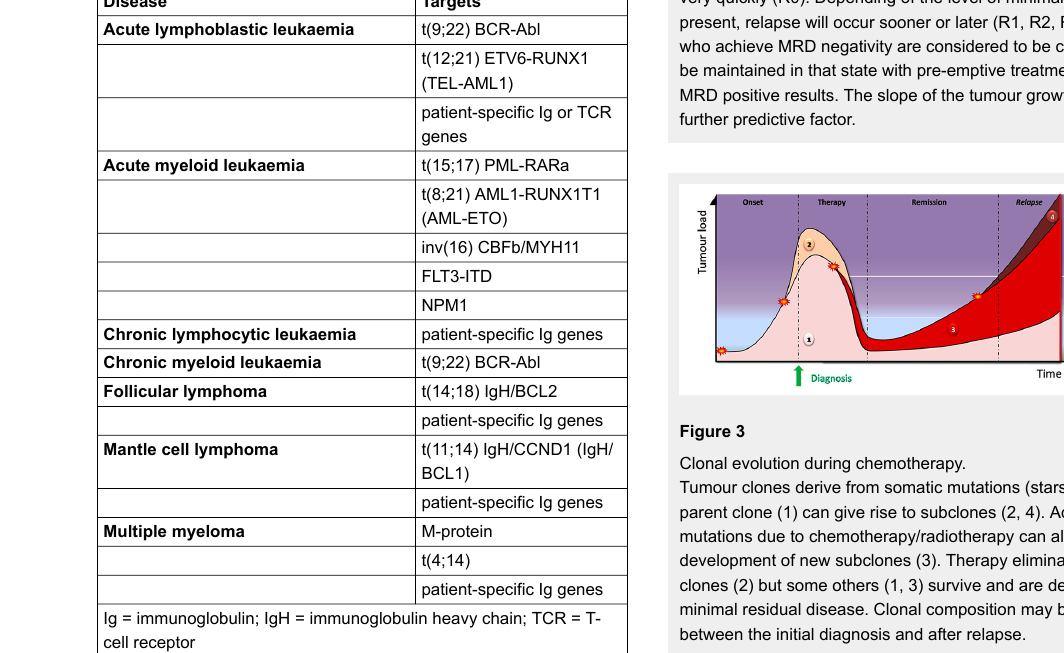
Table 1: Most common genes and translocations used for detection of minimal residual disease. Disease